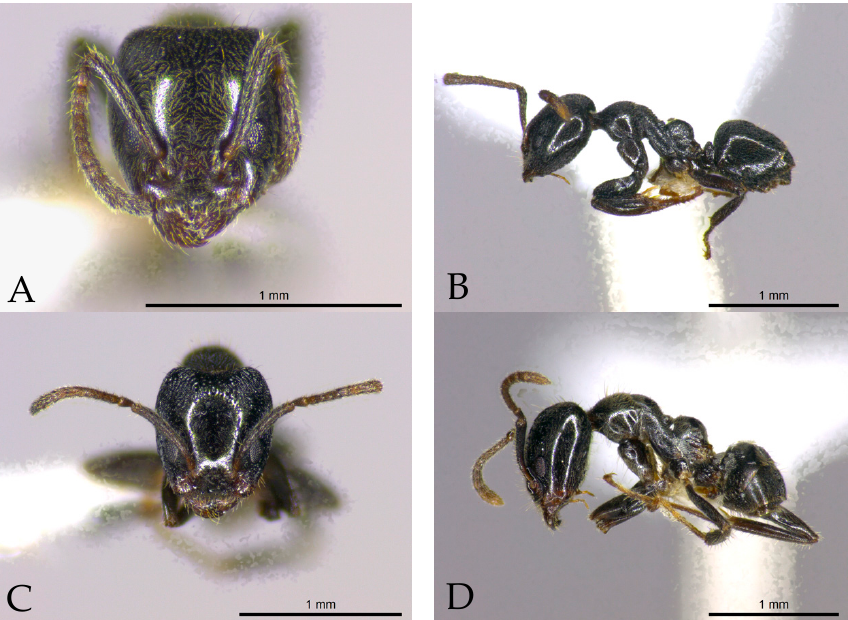
Figure 6. Head and lateral views of Anonychomyrma sp. I ( A , B ) and sp. S ( C , D ).